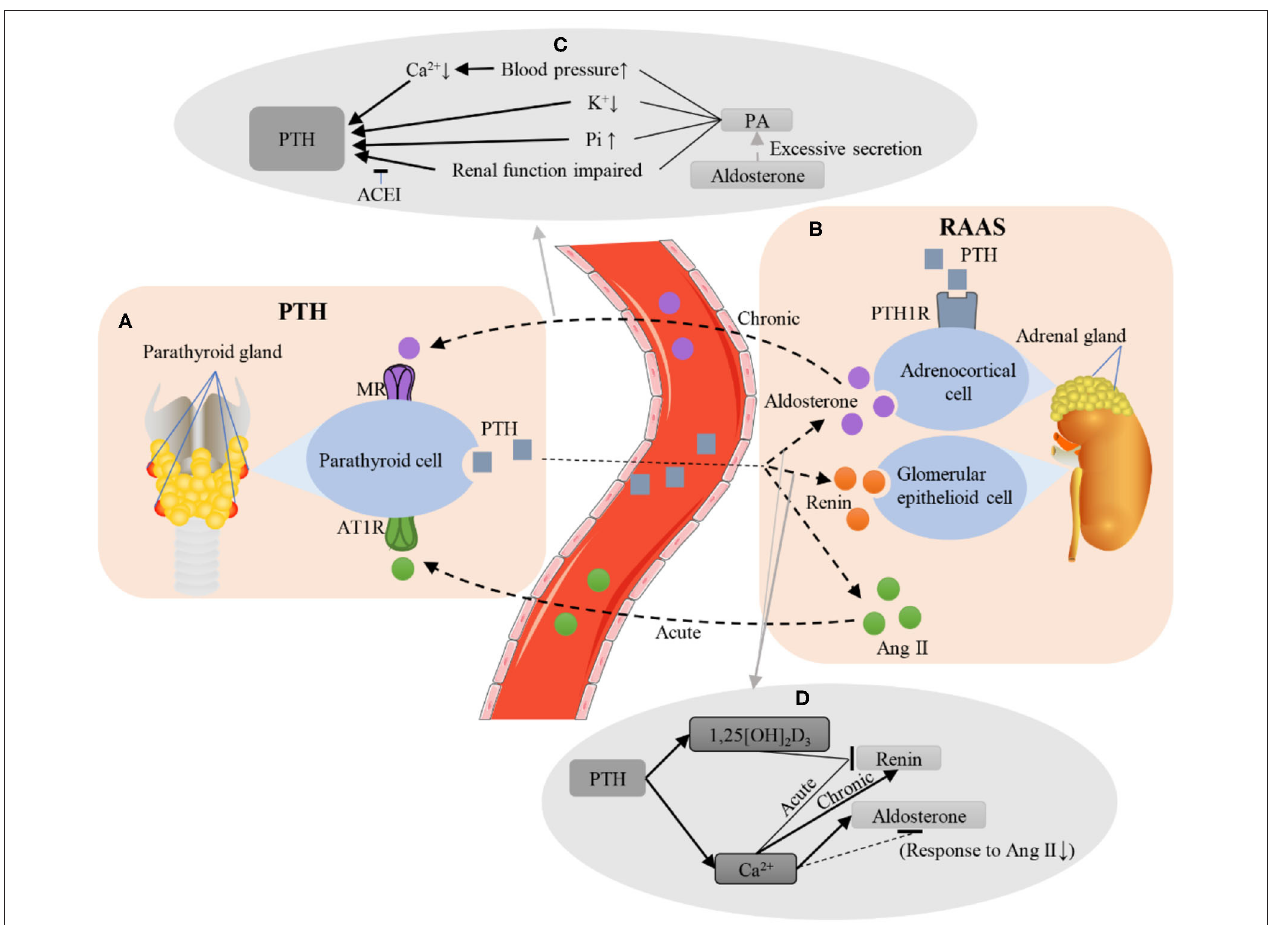
FIGURE 3 | Interactions between the PTH and RAAS. (A,B) Brief illustration of RAAS and PTH. Under chronic conditions, the aldosterone secreted by the adrenal gland binds to the MR of the parathyroid gland. Under acute conditions, Ang II binds to AT1R in the parathyroid gland. PTH can bind to PTH1R in the adrenal gland to promote aldosterone secretion. In addition, PTH secretion can also increase the levels of renin and Ang II. (C) Several possible mechanisms for aldosterone to increase PTH levels. Excessive secretion of aldosterone causes PA, leading to the increase in blood pressure and serum Pi, the decrease in serum Ca 2 + and K + , and the impairment of renal function, finally increasing the level of PTH, while ACEI can protect renal function and reduce PTH levels. (D) The possible mechanism of PTH regulating renin and aldosterone levels. PTH increased the serum levels of 1,25 [OH] 2 D 3 and Ca 2 + . Acute elevation of Ca 2 + and 1,25 [OH] 2 D 3 inhibited renin secretion, while chronic elevation of Ca 2 + could increase the renin level. Ca 2 + can inhibit the diurnal decline of aldosterone, and it may also reduce the level of aldosterone by weakening the response of the kidney to Ang II. PTH, parathyroid hormone; RAAS, renin-angiotensin-aldosterone system; MR, mineralocorticoid receptor; Ang II, angiotensin II; AT1R, angiotensin II receptor 1; PTH1R, PTH1 receptor; PA, primary aldosteronism; Pi, phosphorus; Ca 2 + , calcium ions; K + , potassium; ACEI, angiotensin converting enzyme inhibitor; 1,25 [OH] 2 D 3 , 1,25-dihydroxyvitamin D. ↑ , upregulated; ↓ ,